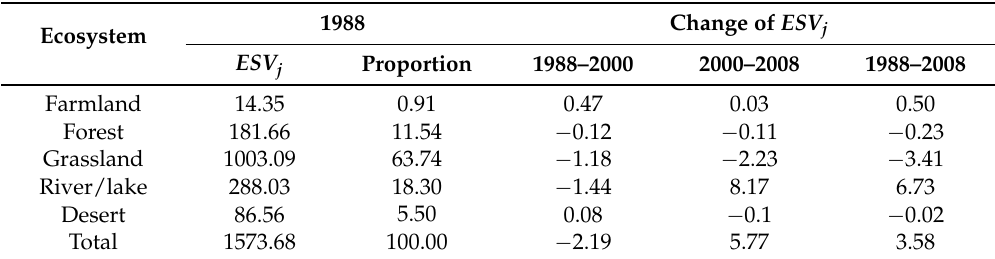
Table 4. Economic value of different ecosystem services and the corresponding proportion in Qinghai Province from 1988 to 2008 (unit: a hundred million yuan; %).